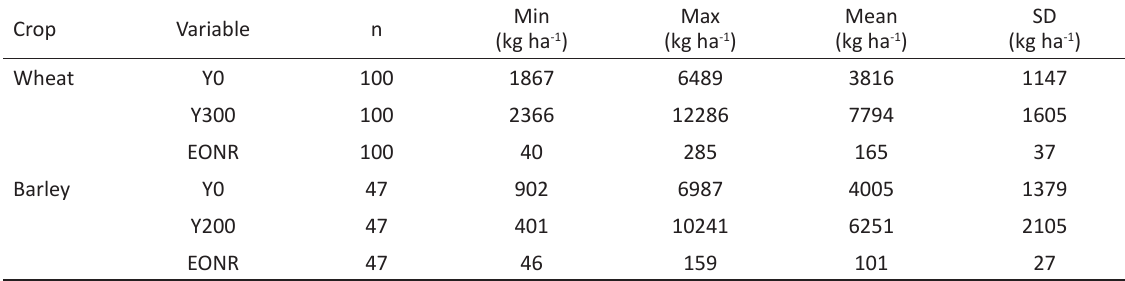
Table 1. Descriptive statistics on the economic optimal nitrogen rate (EONR), the yield at 0 kg N ha -1 (Y0) and the yield at 300 kg N ha -1 (Y300) (wheat) and at 200 kg N ha -1 (Y200) (barley). n = number of trials, SD = standard